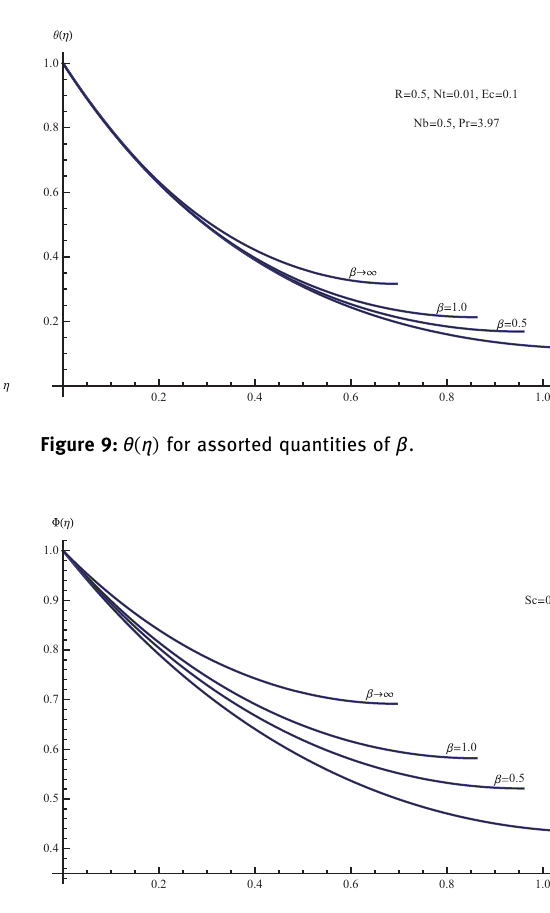
Figure 7: ( ) ϕ η for assorted quantities of M .